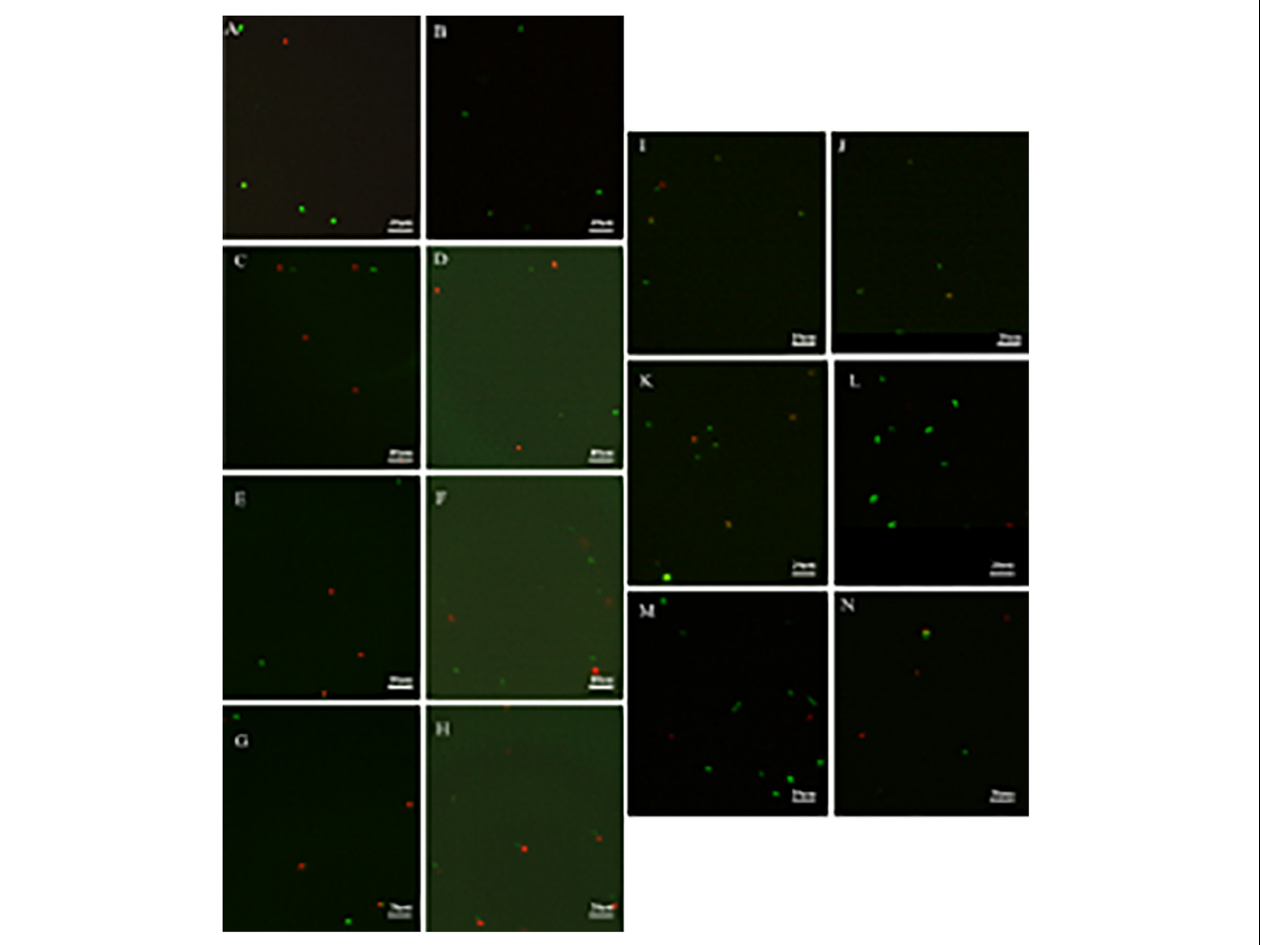
FIGURE 4 | The viability of non-culturable Salmonella stored at different conditions by fluorescent observation ( A,B : group 1; C: group 2; D: group 5; E,F : group 7; G,H : group 9; I,J : group 10; K,L : group 13; M,N : group 14).